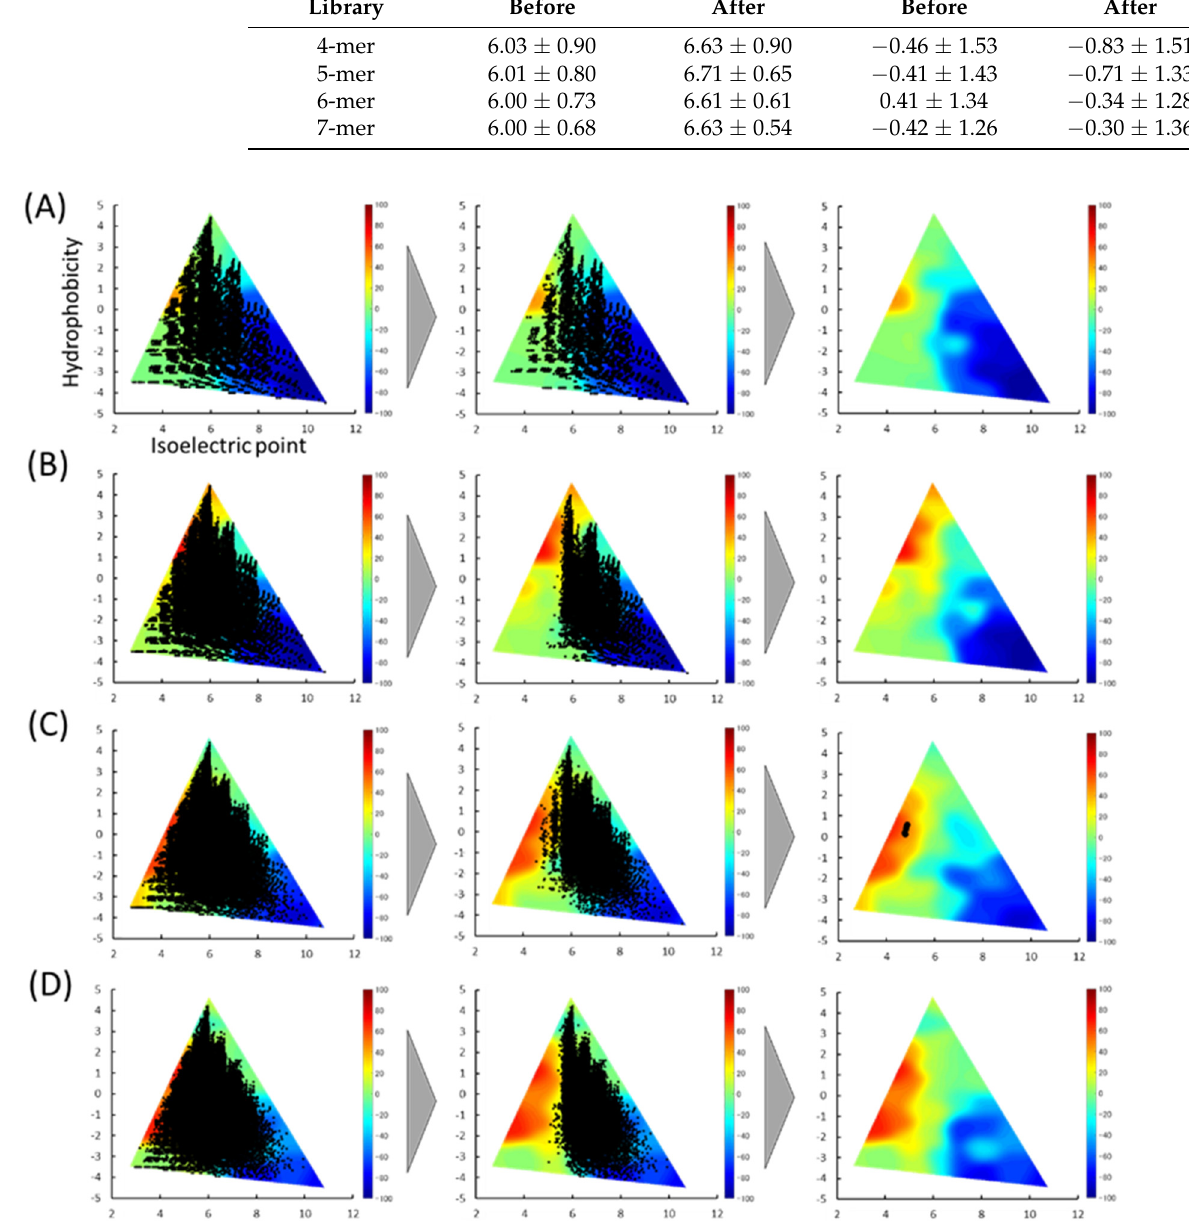
Figure 2. In silico prediction of delivery properties with porous silica gel and selected peptides. Color maps classified by hydrophobicity versus isoelectric point (pI) based on 4-mer ( A ), 5-mer ( B ), 6-mer ( C ), 7-mer ( D ). In the left columns, all peptides stored in the library are indicated as black circles on the color map. In the middle columns, all peptides predicted to be positive are plotted as black circles. In the right columns, peptides with scores >50 are denoted as black circles.